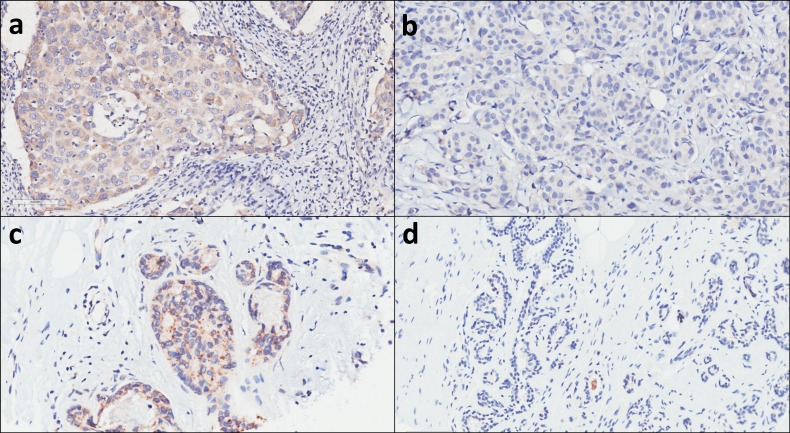
GADD45A expression levels are elevated in human breast cancer samples compared to adjacent non-neoplastic tissues.Representative images from immunohistochemical analysis of GADD45A on (A) high expression in breast cancer tissues, (B) low expression in breast cancer tissues, (C) high expression in adjacent non-neoplastic tissues and (D) low expression in adjacent non-neoplastic tissues.